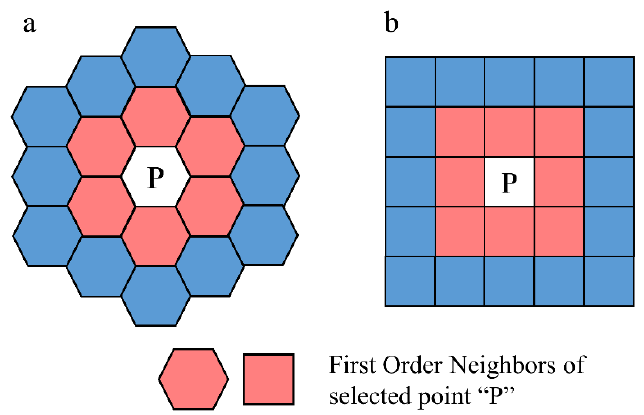
Figure 7. Principle of KAM calculation performed on ( a ) EBSD data; ( b ) simulation results; P stands for the selected point. Red blocks indicate first order neighbors of the selected point. KAM maps measured with EBSD on specimens after tensile deformation are shown in Figure 8.